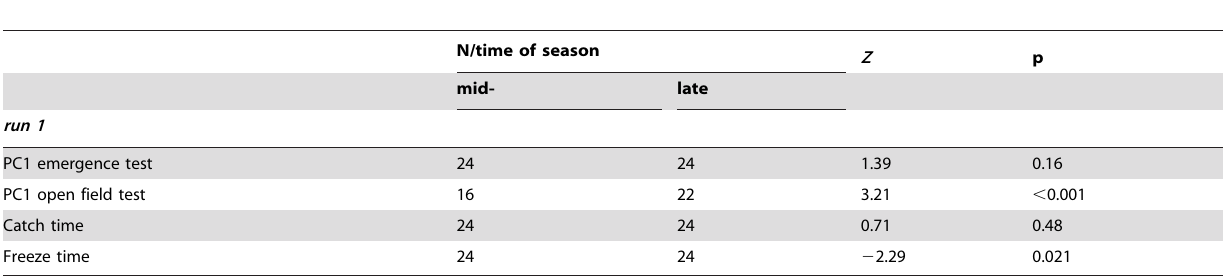
Table 4. Mann-Whitney tests for the behaviour differences observed during mid and late season, respectively, for the first run of four behaviour